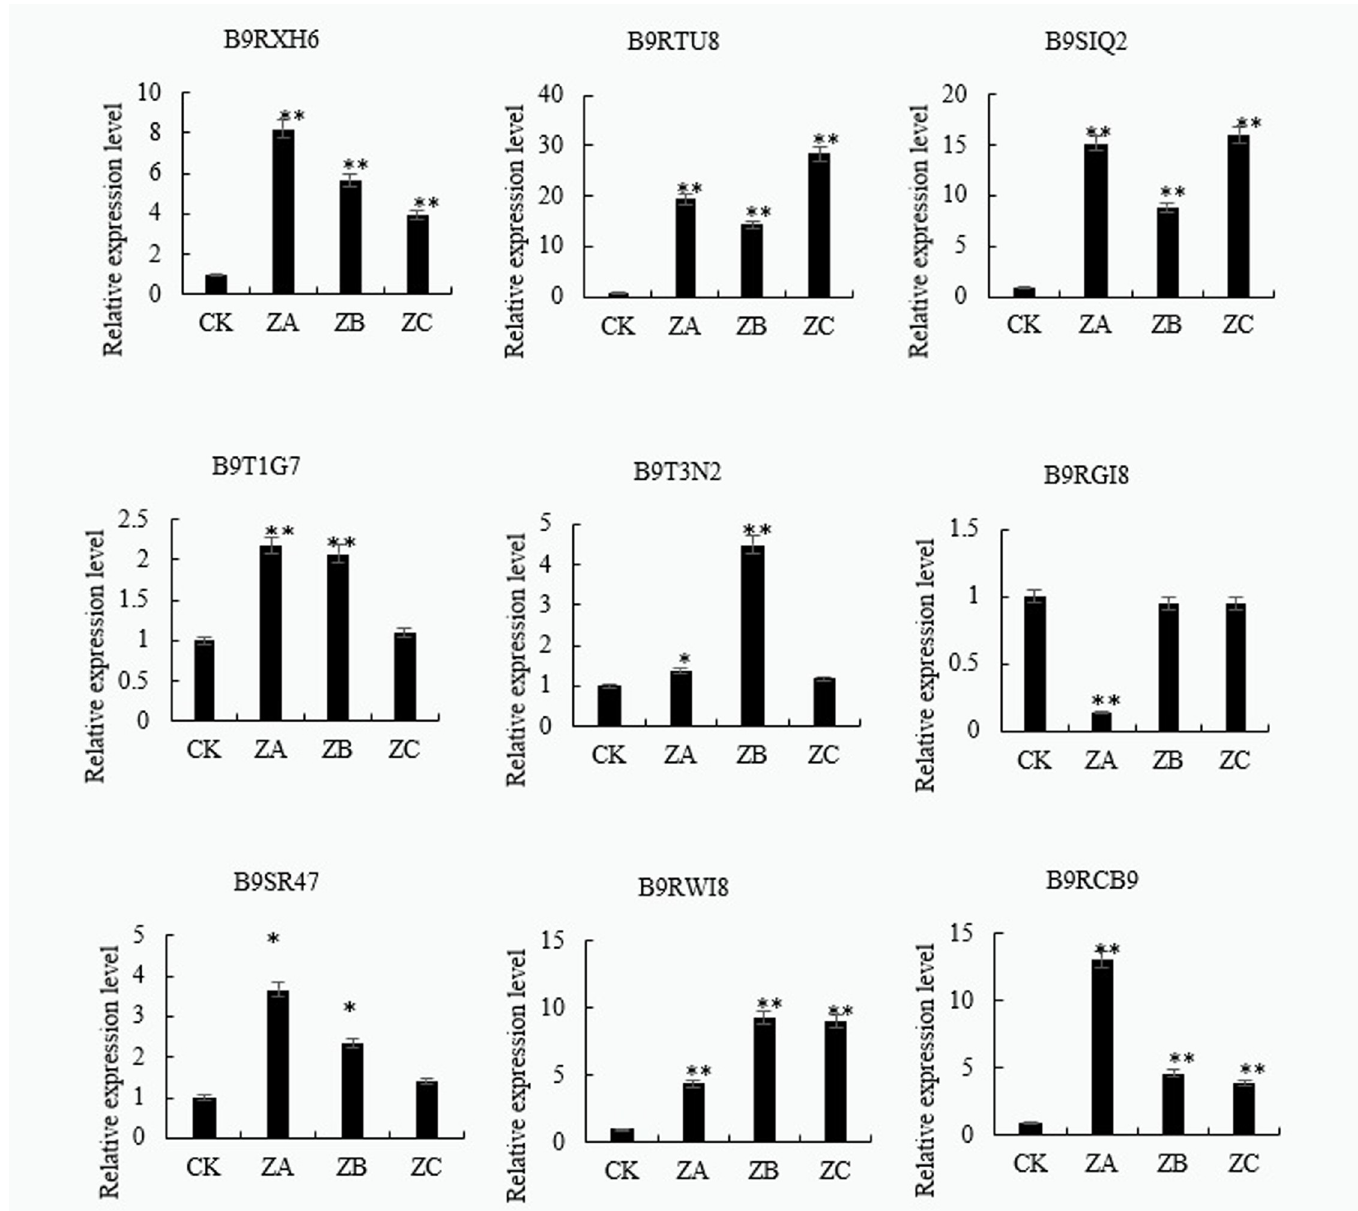
Fig 6. RT-qPCR detection results of some differential proteins in castor plants in response to Cd stress. Note: � : 0.01 < P � 0.05, �� : 0 < P � 0.01.